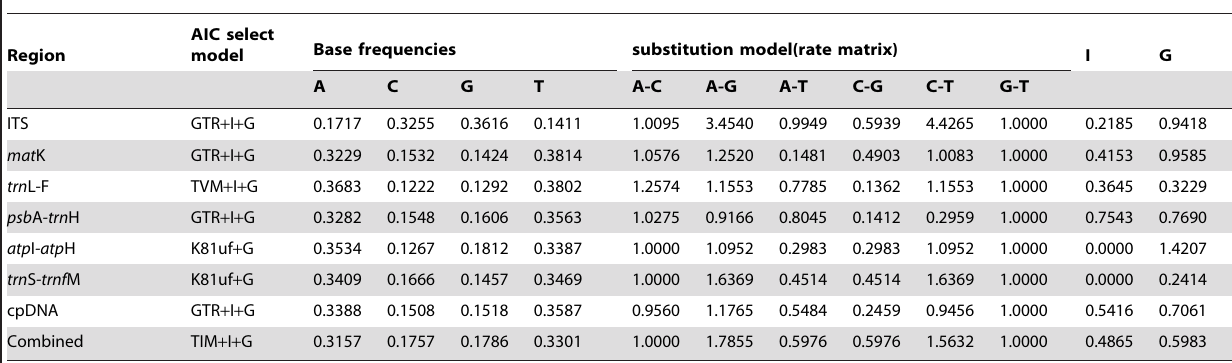
Table 2. Best-fit model and parameter for the analysis datasets.